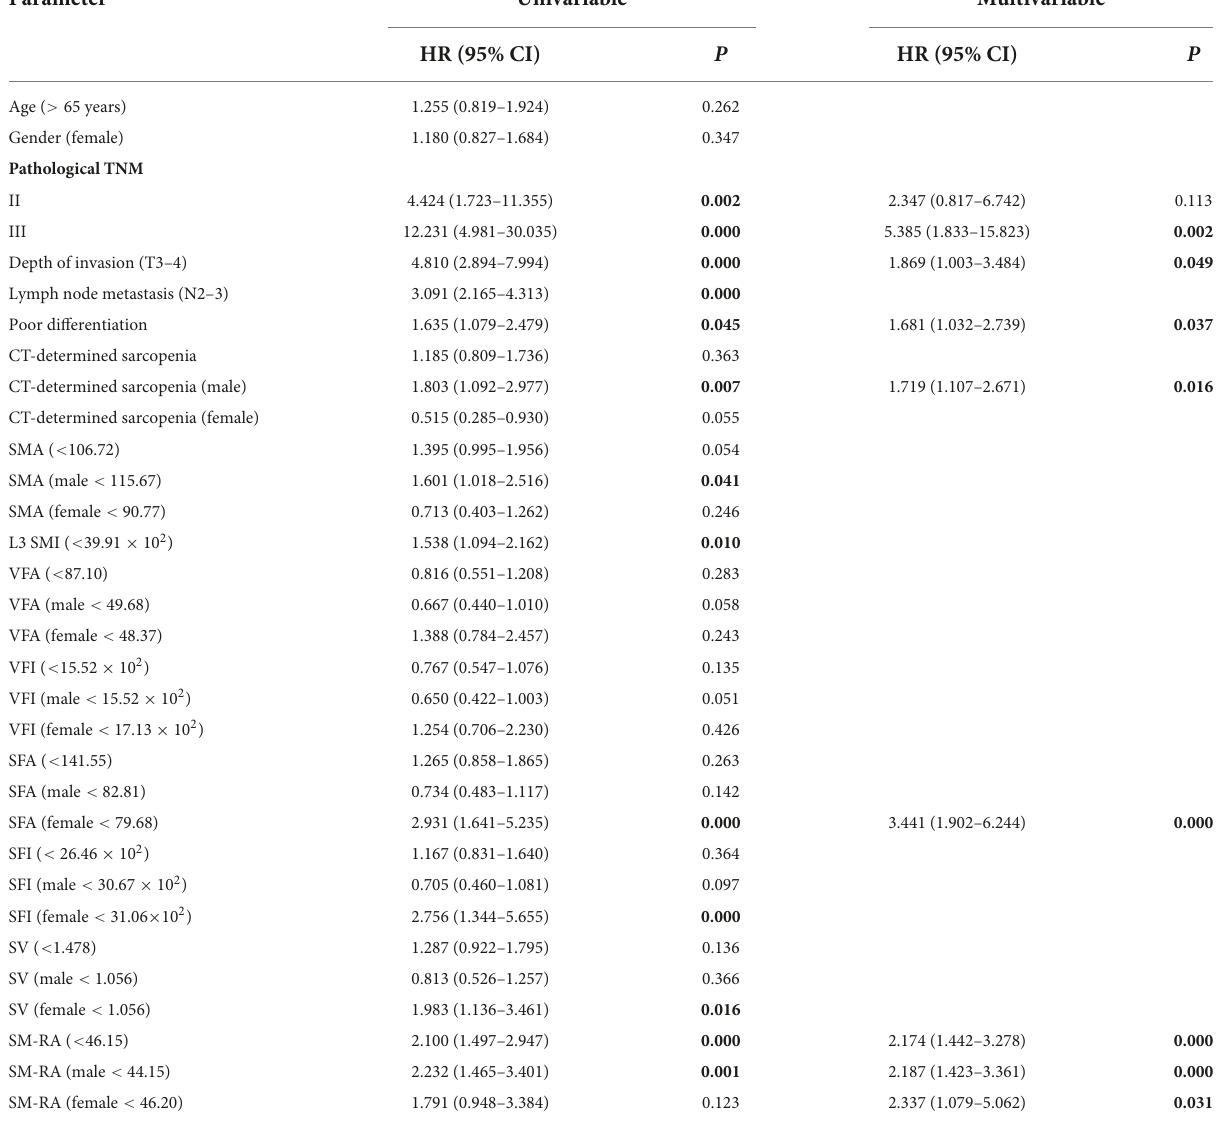
TABLE 3 Results of Cox regression analysis for overall